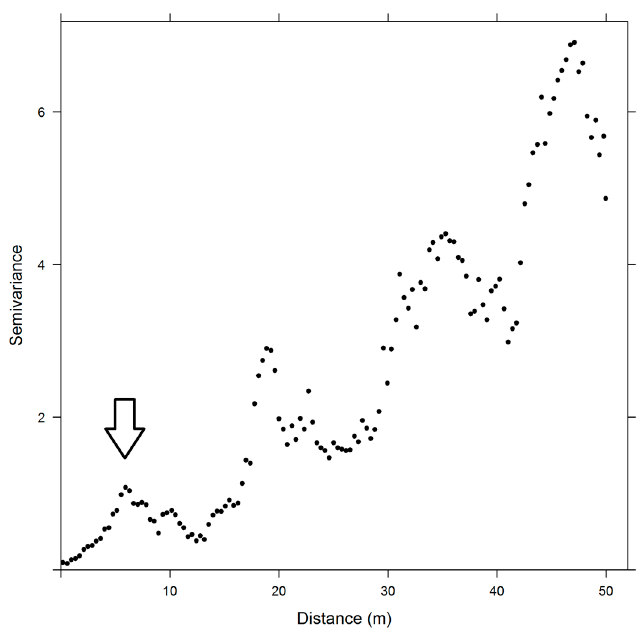
Figure 3. Sample variogram displaying increasing scales of variability (scale domains) with distance.